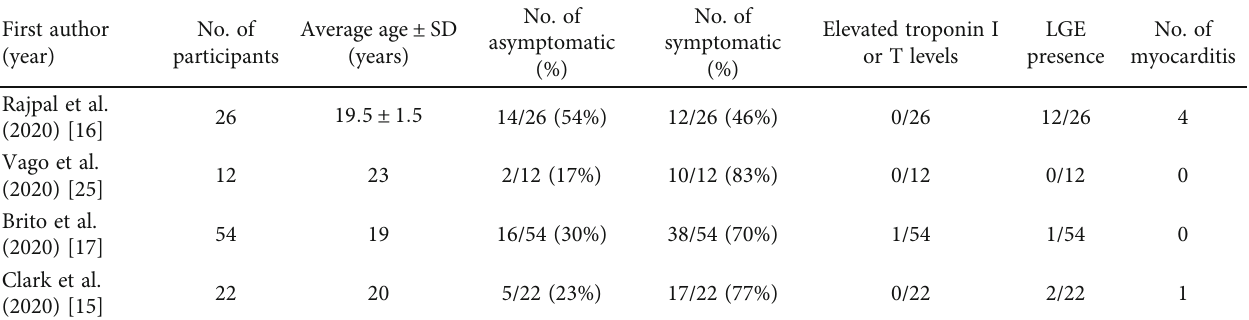
Figure 2: Typical CMR in case 4 of LGE-indicated recent/prior myocarditis. Table 1: Recent reports on cardiac abnormalities in athletes with